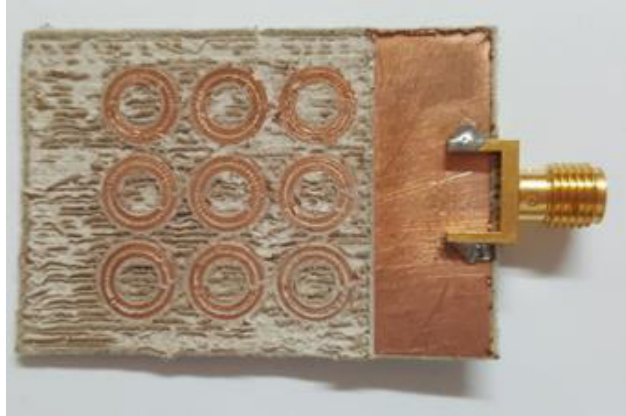
Figure 36. Antennas maximum gain.